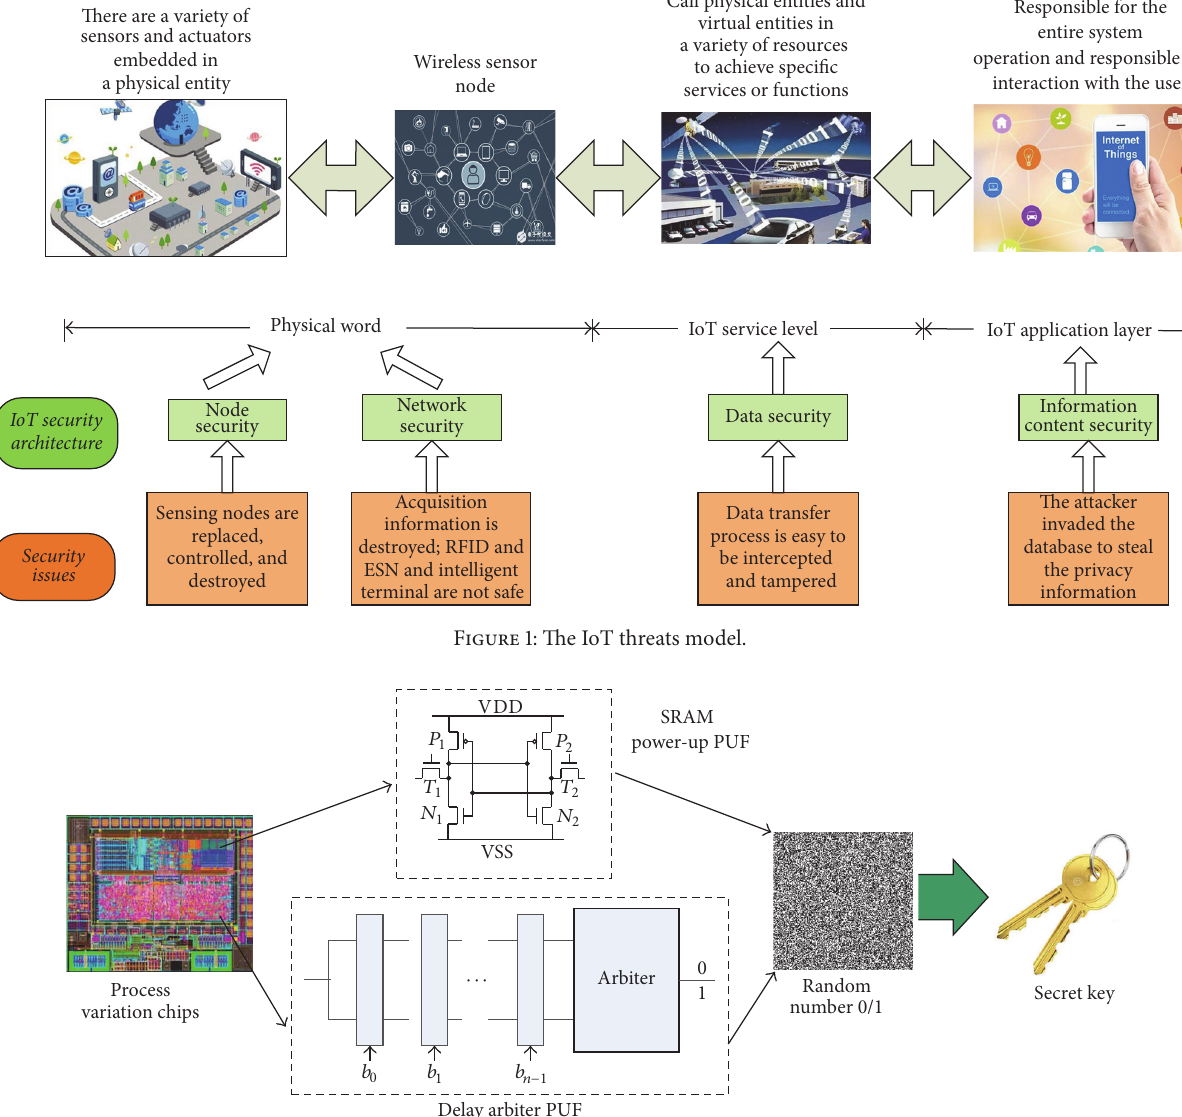
Figure 2: Physical Unclonable Functions